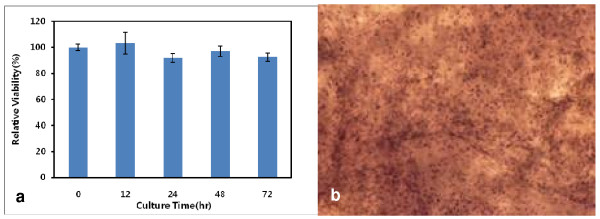
The viability and distribution of chondrocytes within the cell-fibrin gel. a) The relative cell viability profiles assayed by MTT assay. b) The distribution of chondrocytes within the gel.